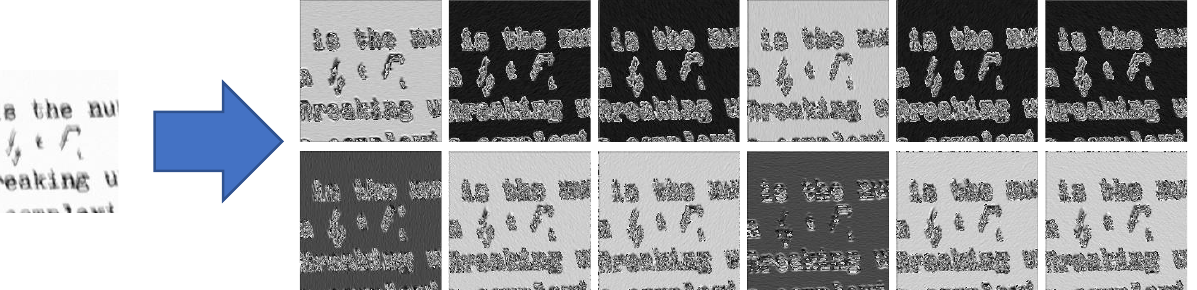
Figure 5. The Gabor filter effect on the input image. The left image is input image and right image is Gabor filter with kernel size 5. The value of theta (rotation angle) changes from 0 to 180 by 30 degrees (from left to right). The value of sigma (standard deviation) changes from 2 to 7 (from top to down). It is clear each parameter setting creates a unique